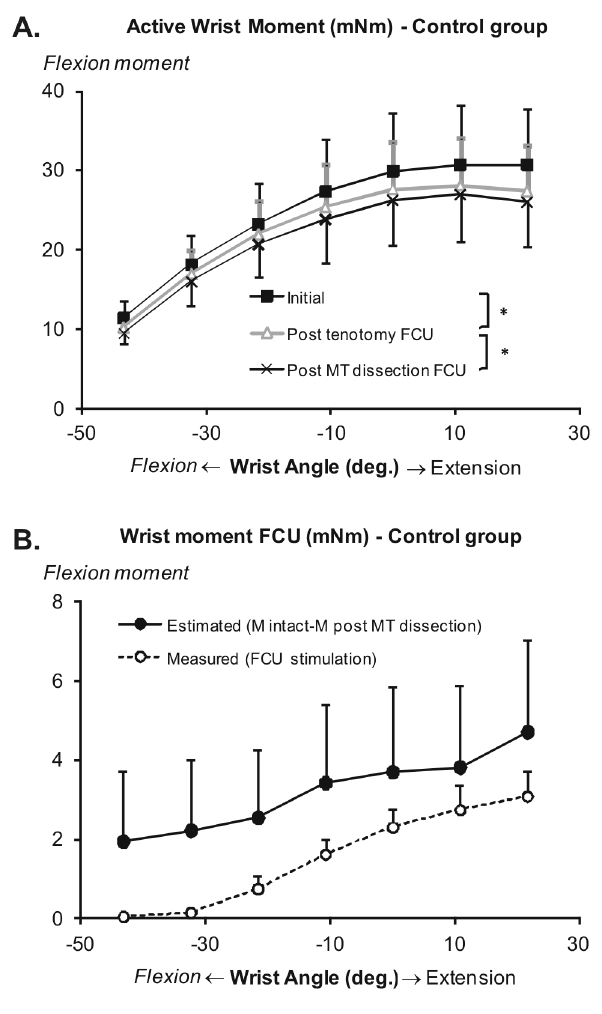
Figure 2. Control group wrist angle-flexion moment characteristics. A. Mean active wrist moment exerted by wrist flexors on simultaneous stimulation of ulnar and median nerves as a function of wrist angle. Asterisk denotes significant differences (p < 0.05) between successive conditions related to state of dissection. Values are shown as mean + or - SD (n =